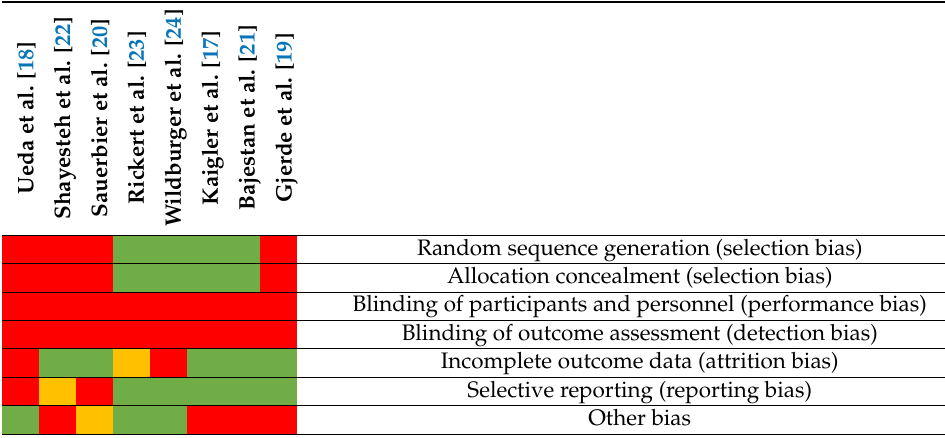
Blinding of participants and personnel (performance bias) Blinding of outcome assessment (detection bias) Incomplete outcome data (attrition bias) Selective reporting (reporting